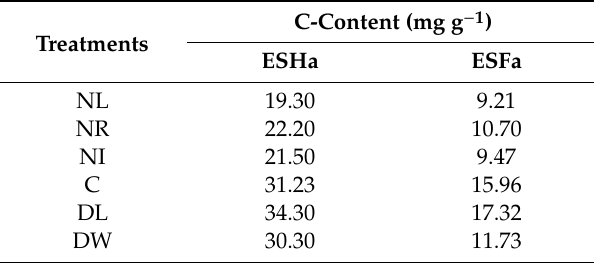
Table 3. C content of each humus fraction (mg g − 1 ).